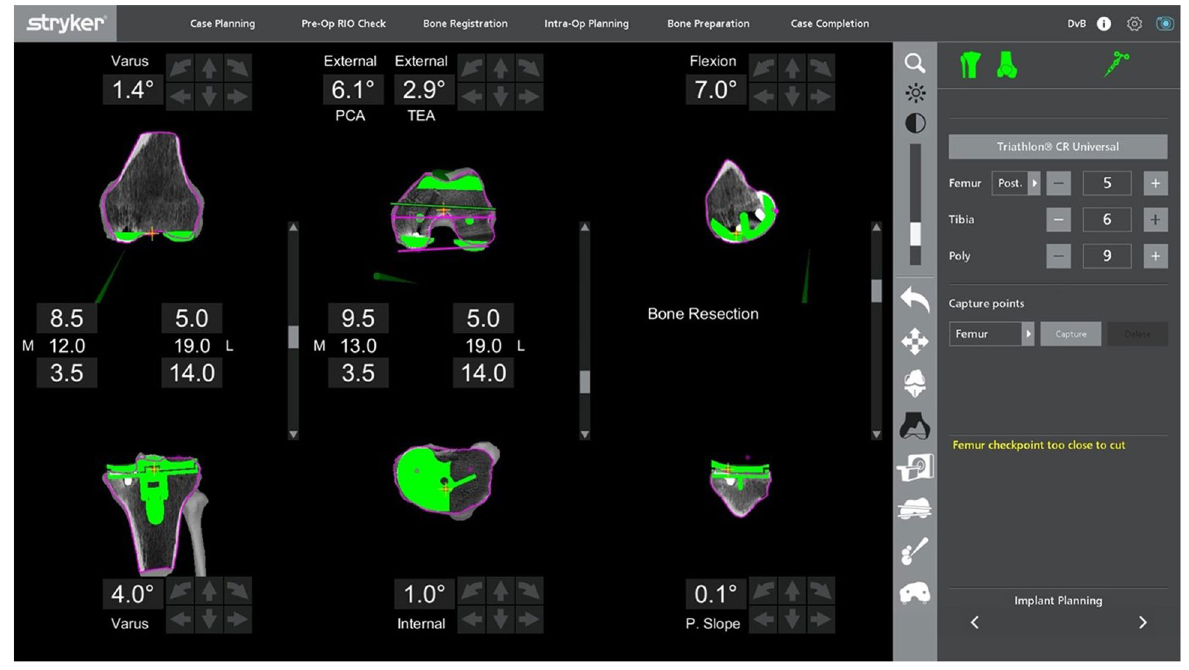
Fig. 3 Scaled image of the preoperative plan for visualization of stem placement